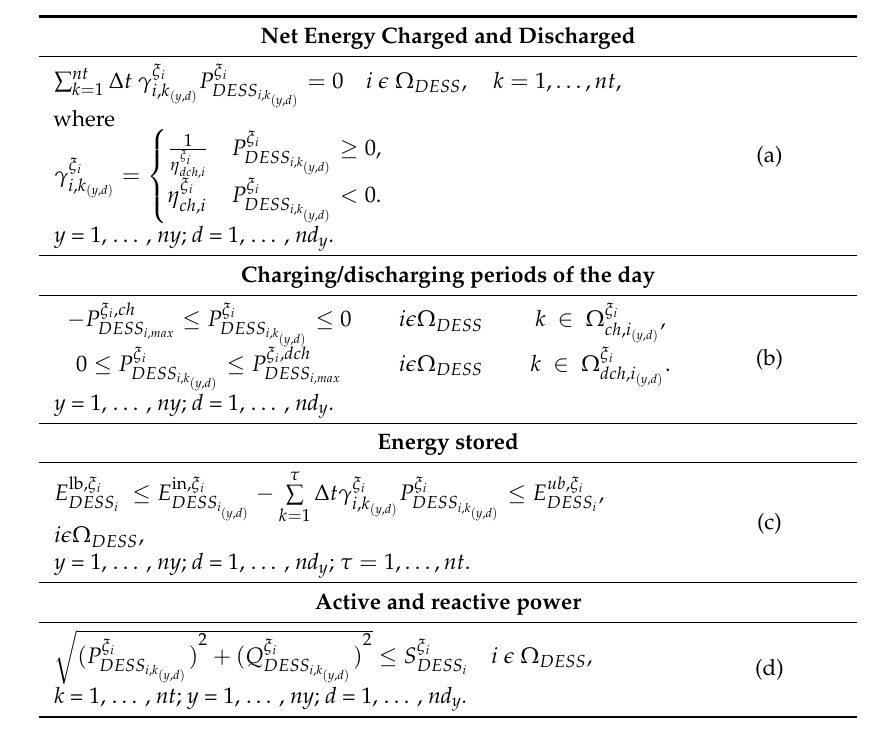
Table 2. Constraints on the Operation of DESSs.